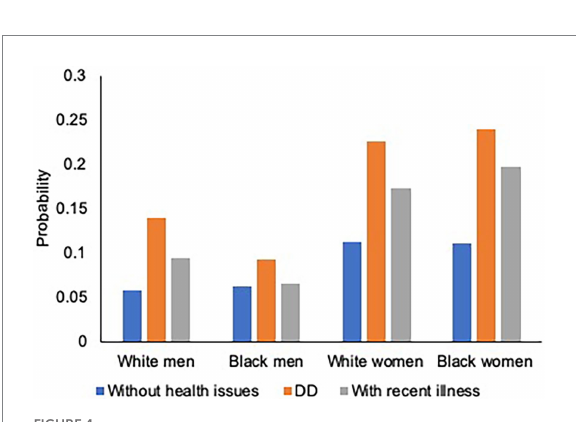
FIGURE 4 Parental Health by Race, Gender, and Parenting Type: Functional Limitations. Figure was based on the three-way interaction results in Table 4. Controlled for covariates and cumulative early life adversities (ELAs). DD refers to DD: Developmentally Disabled.